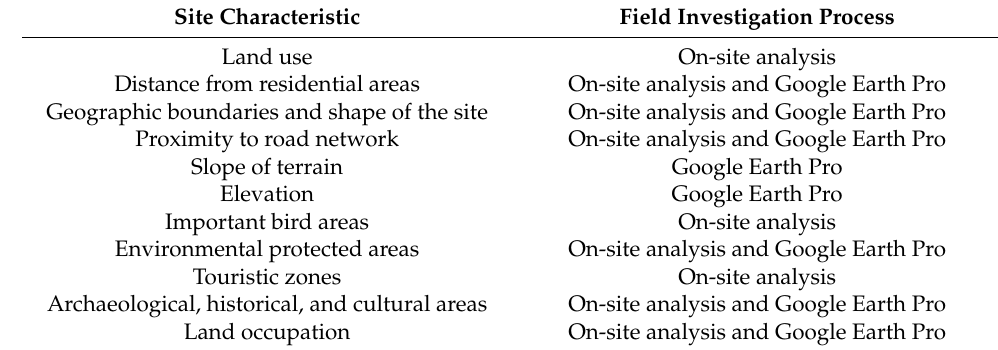
Table 5. Site characteristics examined in the present investigation within the Field Investigation